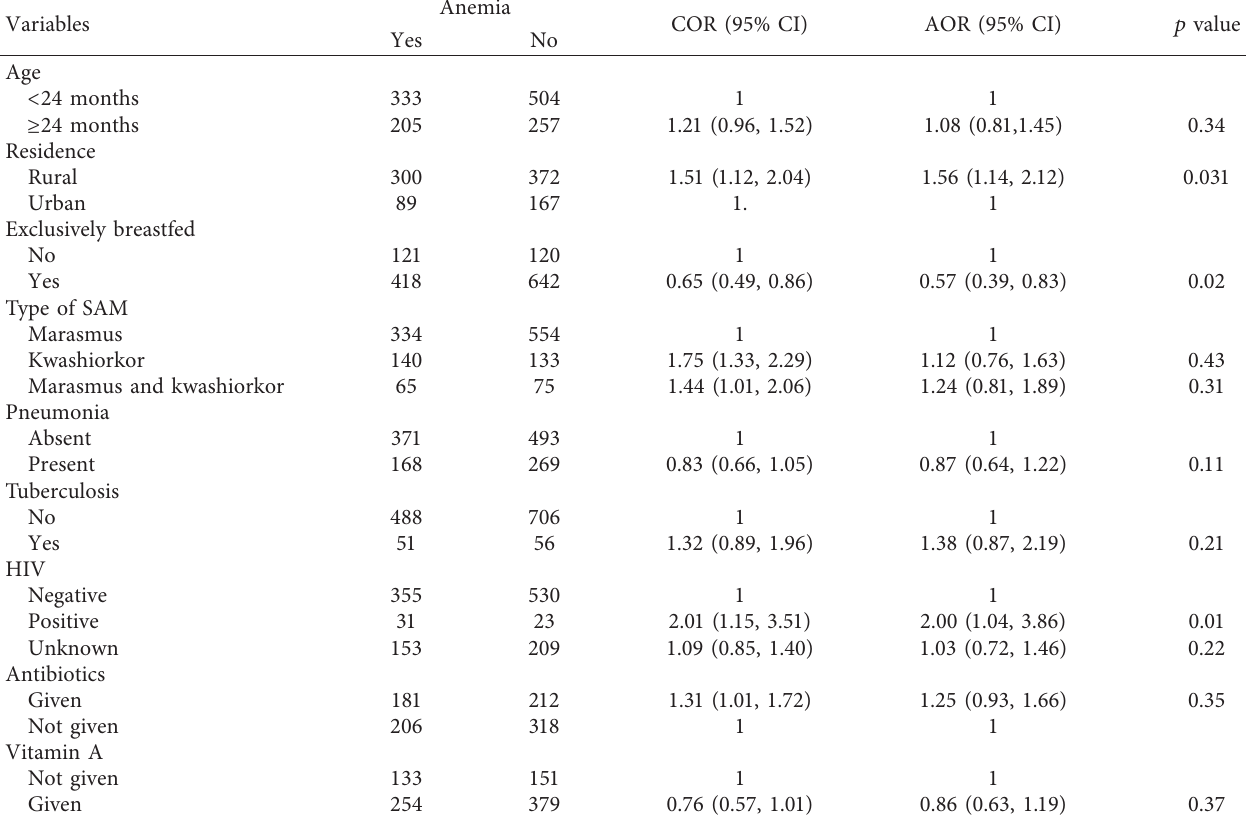
Table 2: Factors associated with anemia among children with SAM aged 0–59 months in the Amhara regional state, northwest Ethiopia,